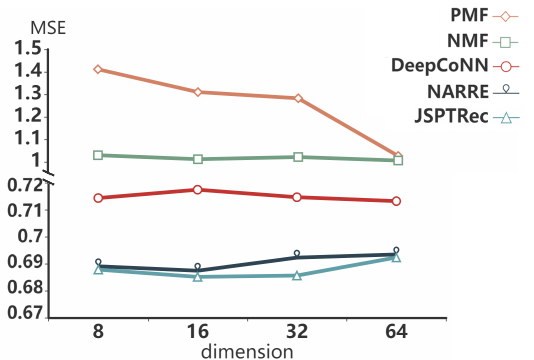
Figure 2. MSEs on the Musical Instruments dataset with different numbers of dimensions for the user and item